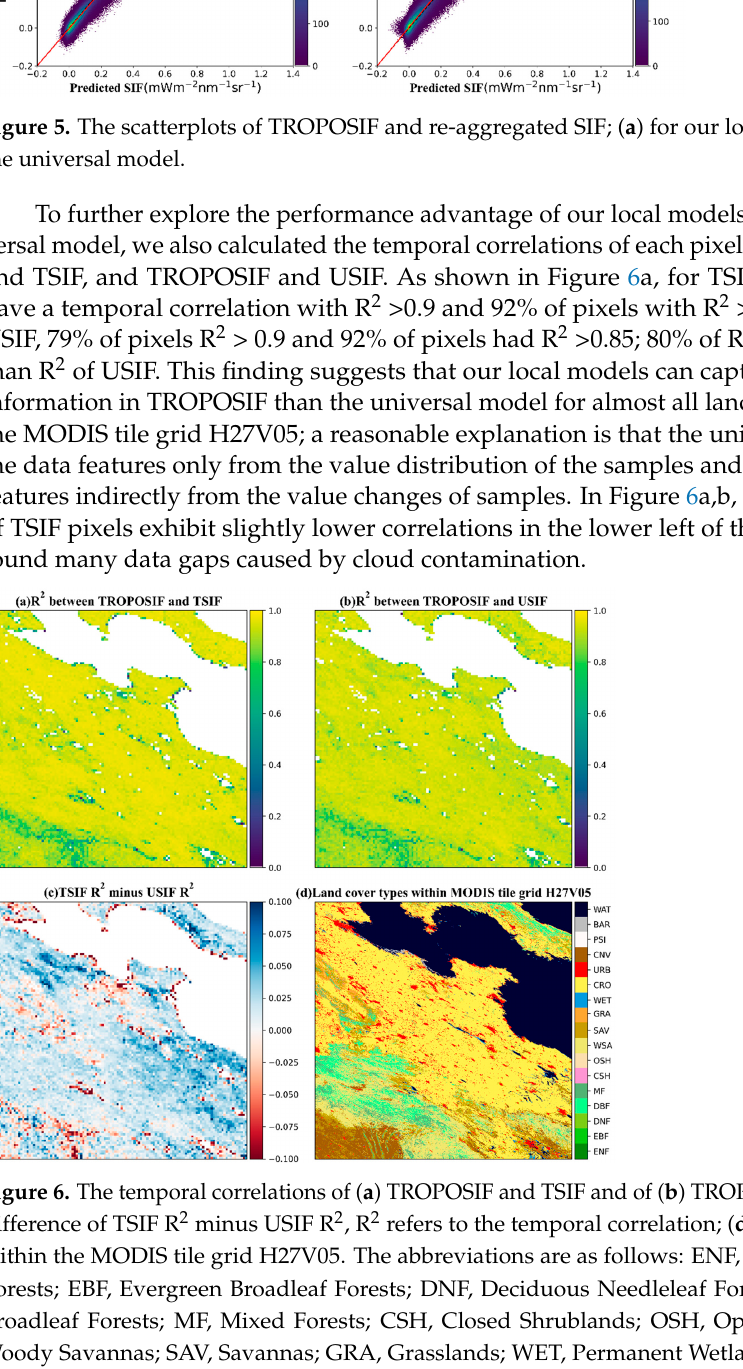
and Ice; BAR, Barren; WAT, Water